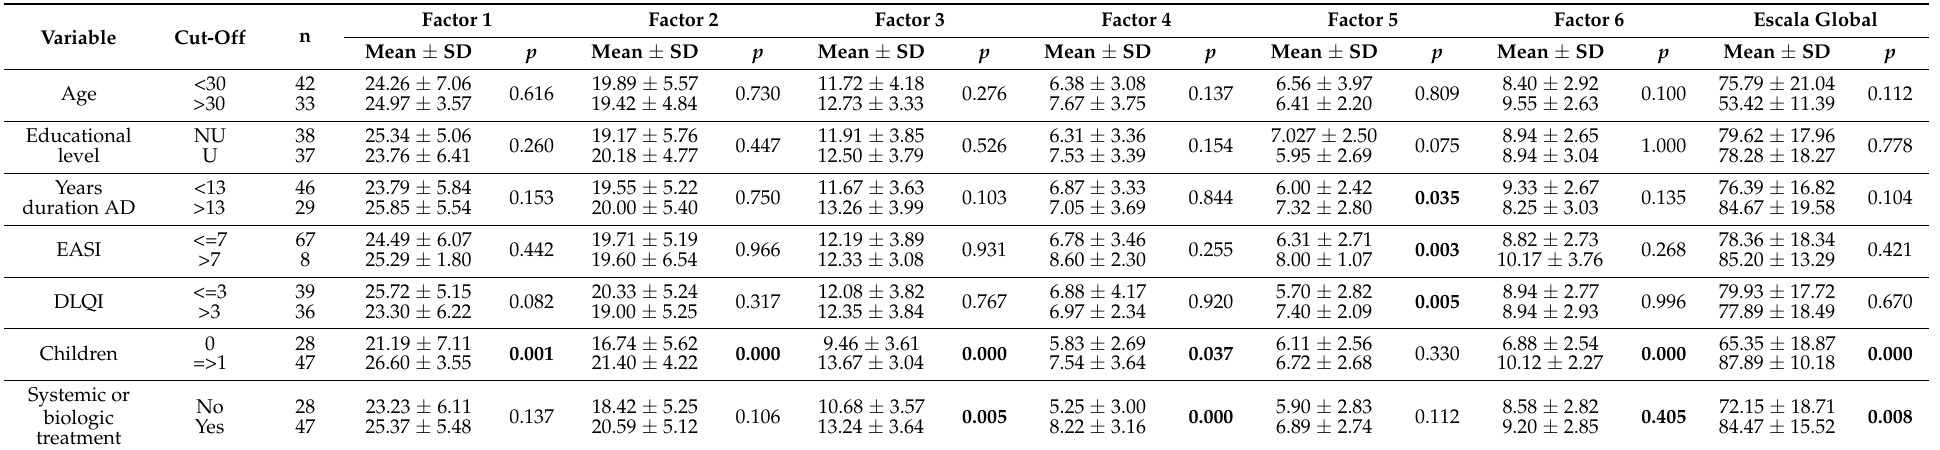
Table 5. Relationship between scales and variables in the AD